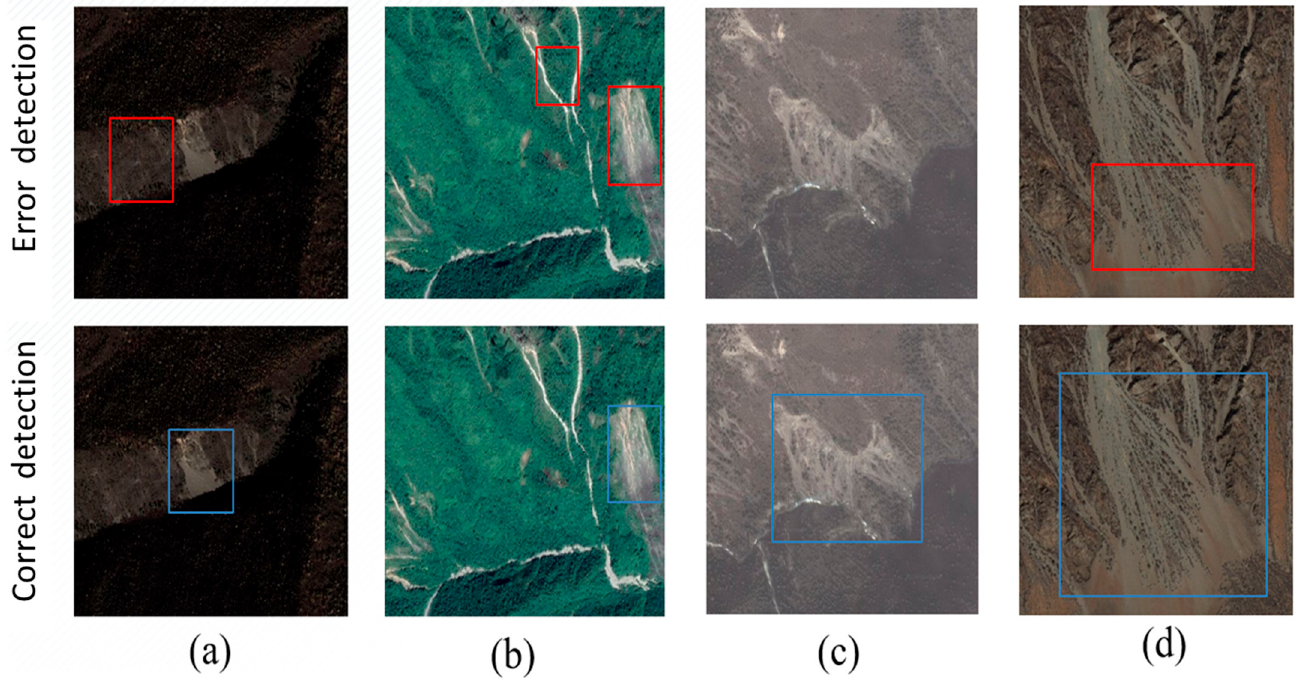
Figure 1. Errors in detection using a lightweight landslide detection network. ( a ) Missing detection, ( b ) false detection, ( c ) failure to detect, and ( d ) a detection range that is too small. The red squares and the green squares are the landslide areas predicted by the model.